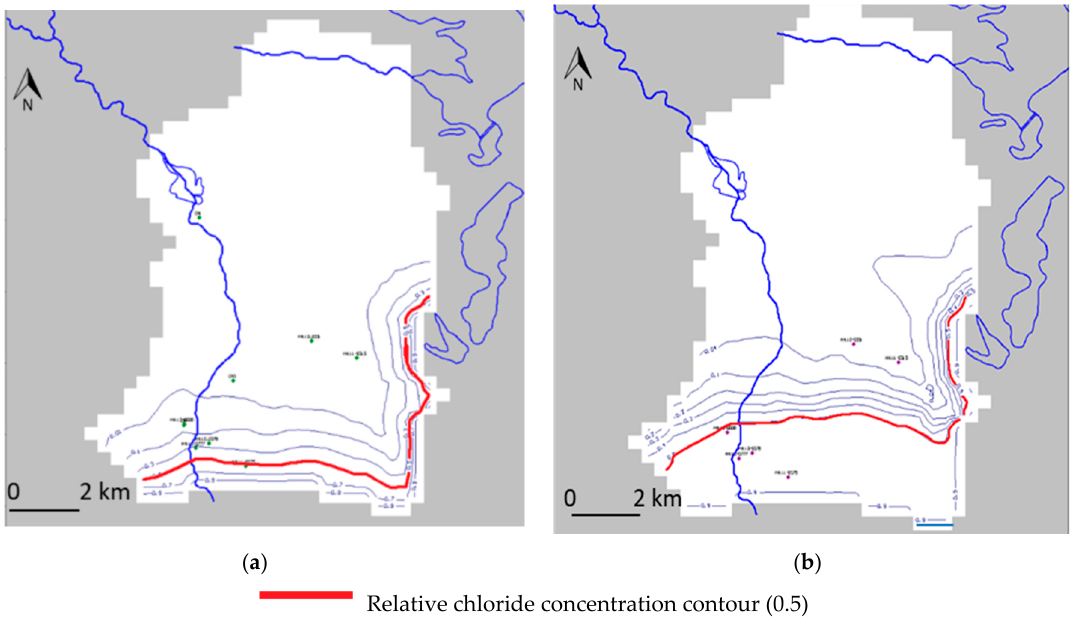
Figure 3. Results of numerical simulations for Kiti pilot area: Relative chloride concentrations ( a ) for the base hydrological year (end of dry period), and ( b ) for extreme dry hydrological year, based on the MPI- RCA4 model under the RCP 4.5 scenario (end of dry period). Relative chloride concentration of 1 expresses the seawater chloride concentration (22 g/L). [32].